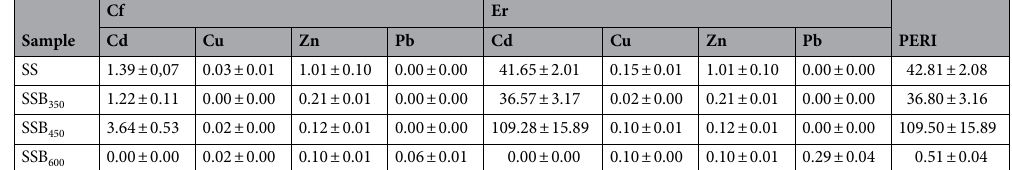
Table 5. Effect of the pyrolysis temperature on contamination factor (Cf), potential ecological risk coefficient (Er) and potential ecological risk Index (PERI) of the sewage sludge (SS) and sewage sludge biochar